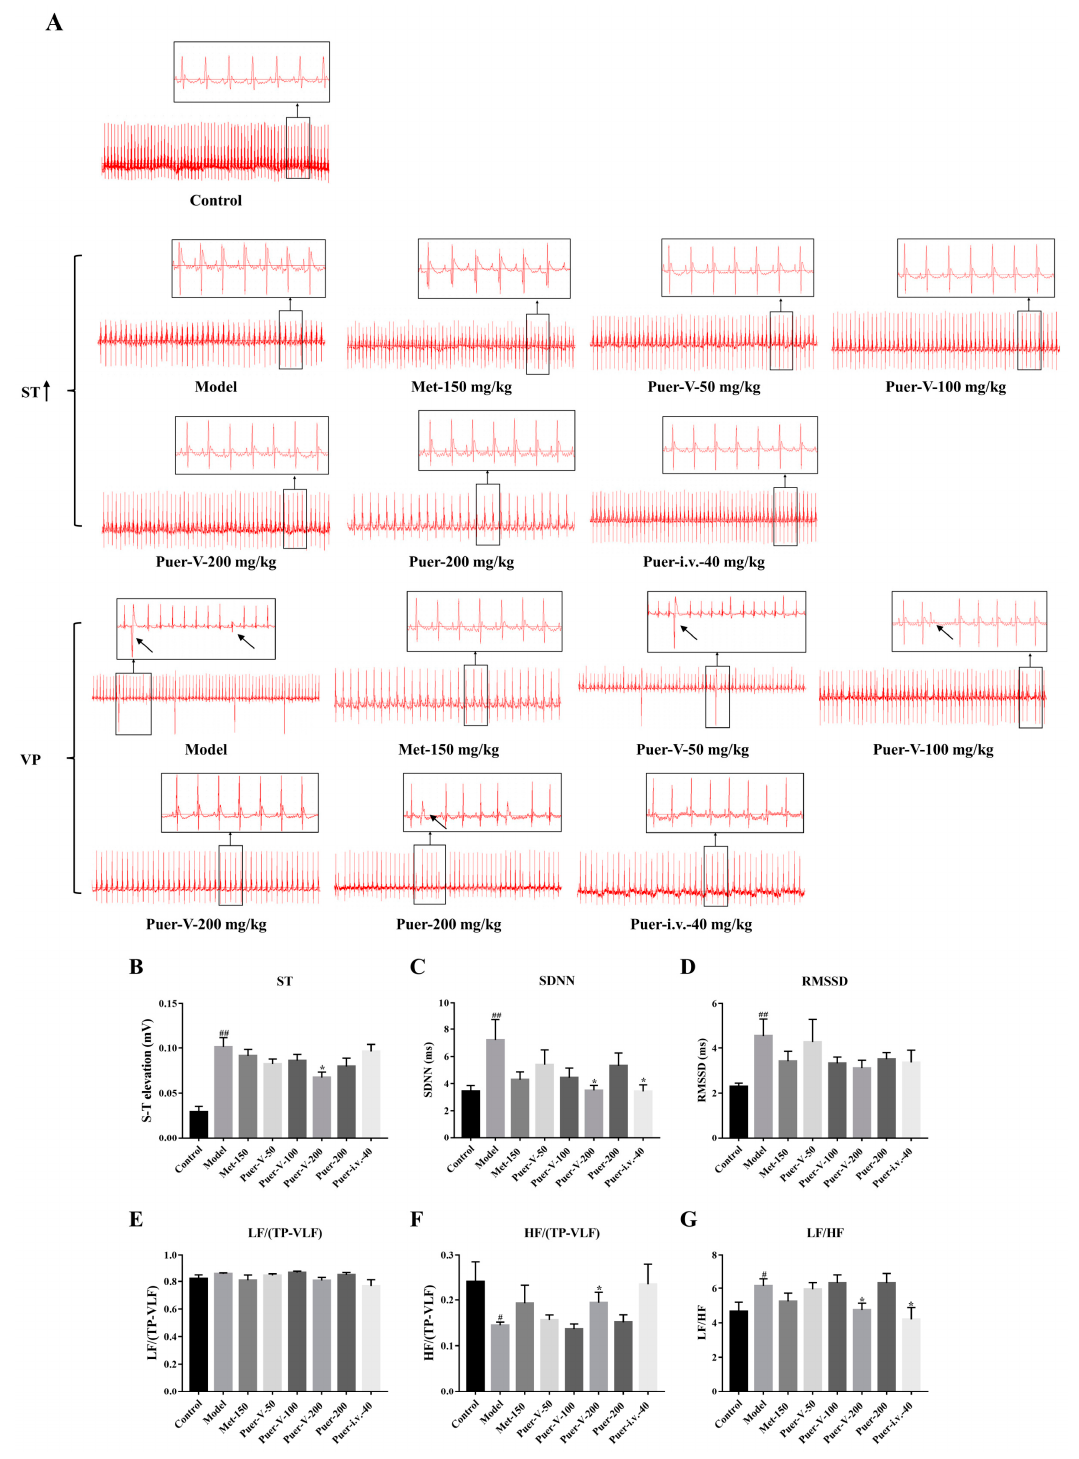
Figure 3. Puerarin-V attenuated the electrocardiographic changes induced by diabetes. ( A ) Rep- resentative images of typical electrocardiogram of different groups. ( B ) ST-segment of different groups. Puerarin-V improved the levels of standard deviation of NN intervals (SDNN) ( C ), root mean square difference between adjacent RR intervals (RMSSD) ( D ), normalized value of low fre- quency (LF/(TP-VLF)) ( E ), normalized value of low frequency (HF/(TP-VLF)) ( F ), and low frequency (LF)/low frequency (HF) ( G ) in rats subjected to diabetic cardiomyopathy. The data are represented by mean ± SEM (n = 6–8). # p < 0.05 and ## p < 0.01 vs. control group. * p < 0.05 vs. model